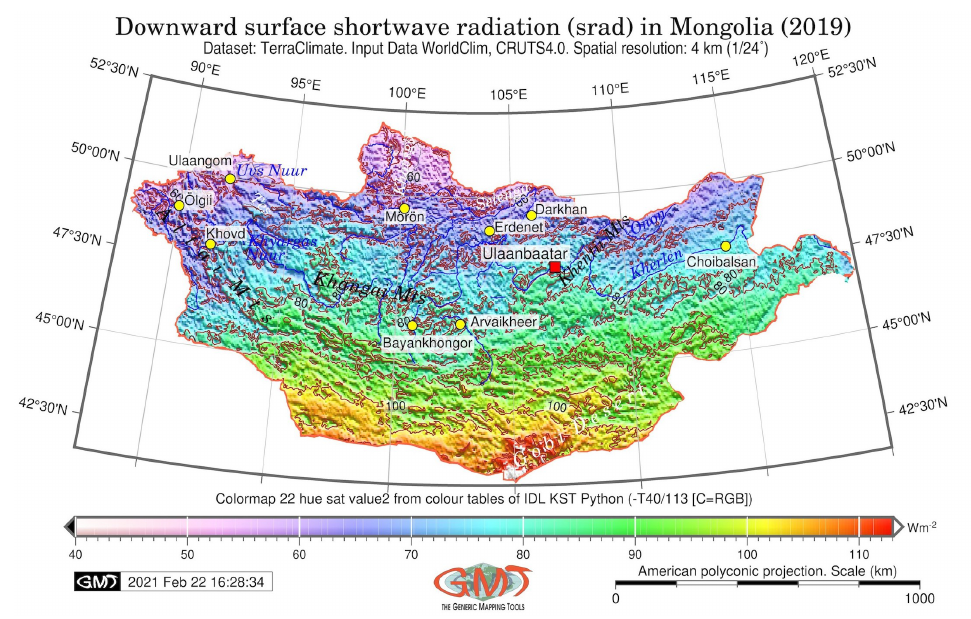
Figure 6. Downward surface shortwave radiation in Mongolia in 2019. Mapping: GMT by script available in Appendix B.5. Source: